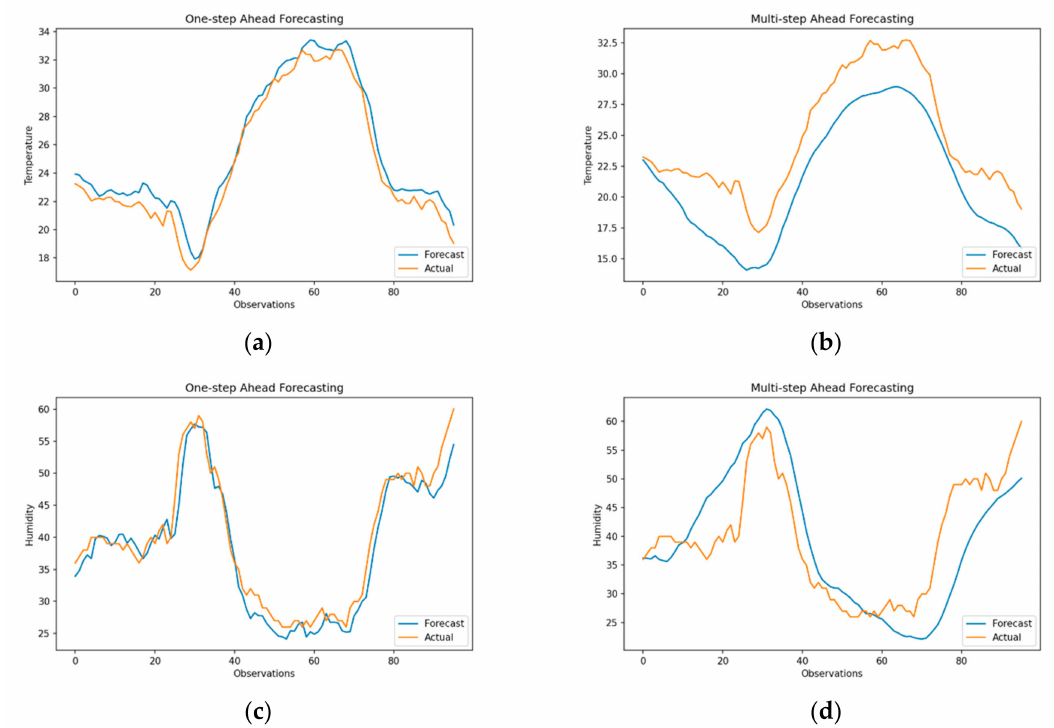
Figure 7. Forecast using Multilayer Perceptron (MLP) ( a ) One-step ahead Temperature ( RMSE = 1.141) ( b ) Multi-step ahead Temperature ( RMSE = 7.513) ( c ) One-step ahead Humidity ( RMSE = 2.873) ( d ) Multi-step ahead Humidity ( RMSE = 14.486) ( top-left, top-right, bottom-left, bottom-right